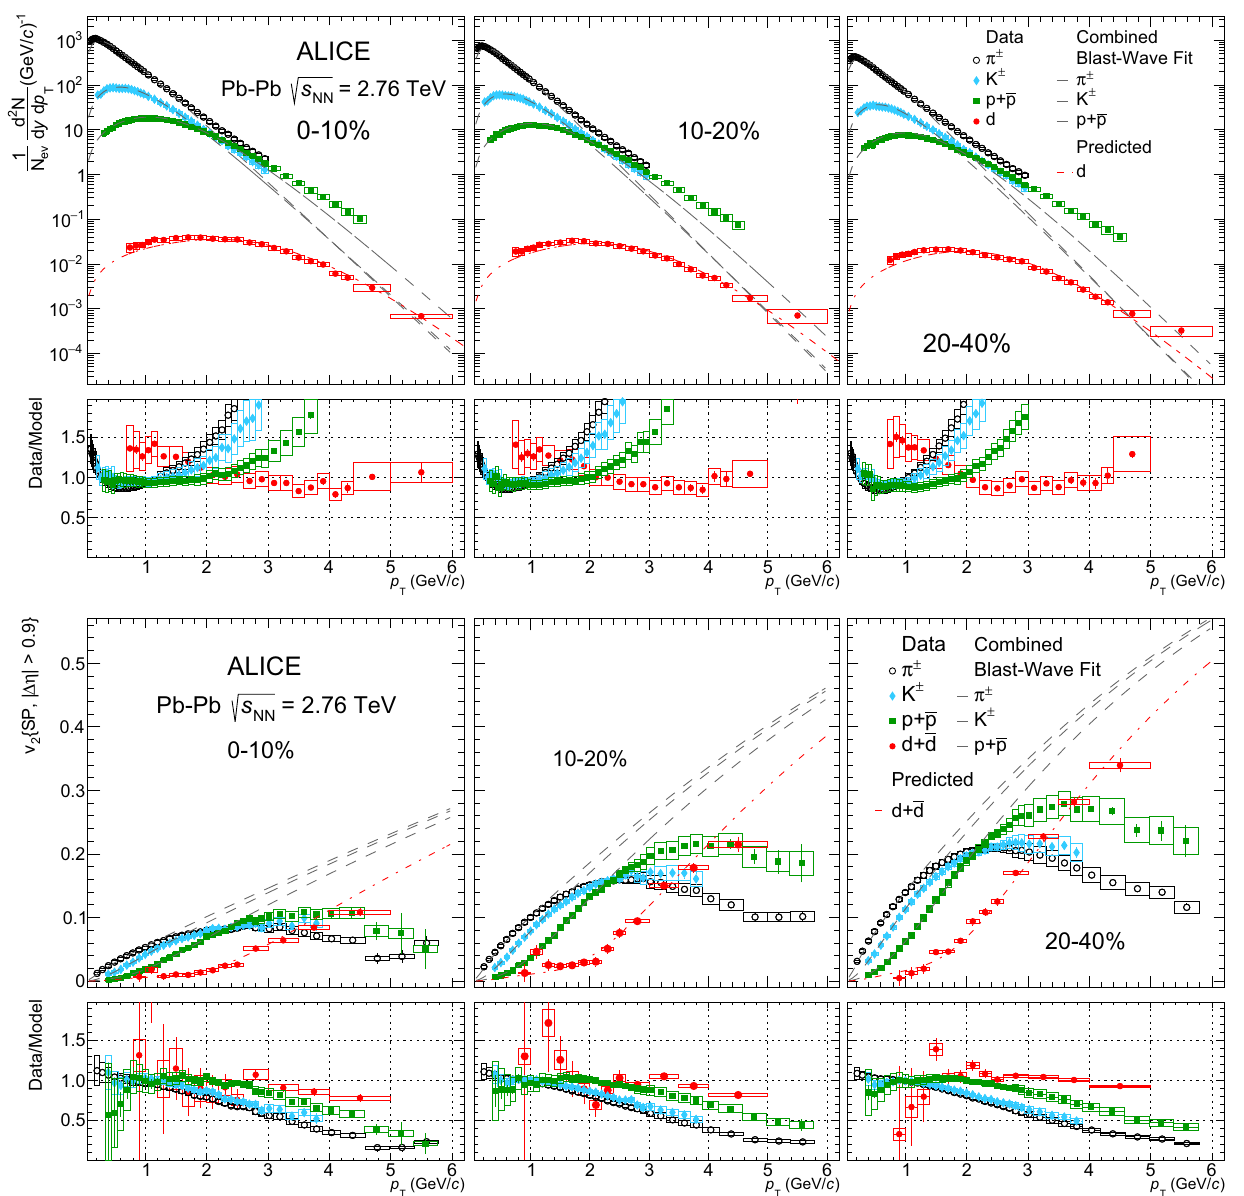
Fig. 7 Combined Blast-Wave fit to p T and v 2 ( p T ) distributions using shown. For π ± , K ± and p+p the long dashed curves represent the com- Eqs. 8 and 10. The six upper panels show the p T spectra and the ratio bined p T and v 2 Blast-Wave fit. Deuteron curves (dash dotted lines) are between data and fit, while the six panels in the bottom part shows the predictions from lighter particles Blast-Wave combined fit. Each col- v π ± (empty cir- umn shows a different centrality intervals (0–10% left, 10–20% middle 2 ( p T ) and the ratio between data and fit. In each panel, and 20–40% cles), K ± (diamonds), p+p (filled squares) and d+d (filled circles) are